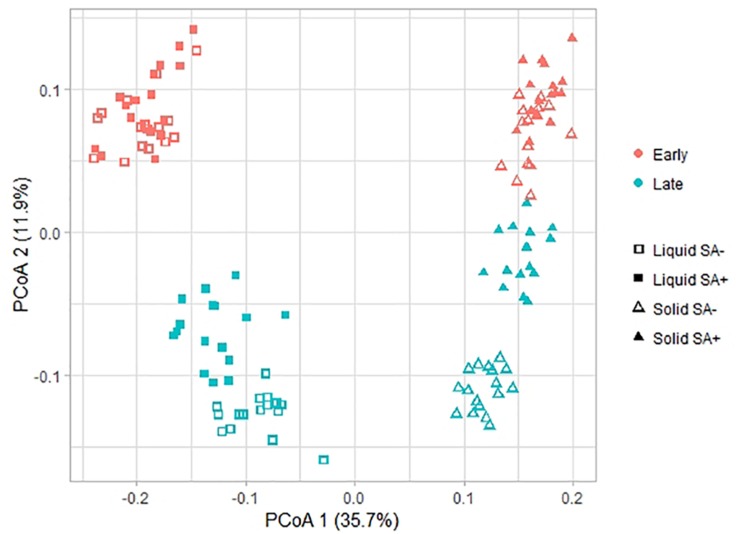
Changes in prokaryotic community composition associated with the time point, phase, and sucrose addition visualized as a principal co-ordinate analysis (PCoA) using weighted UniFrac distance metrics. Symbol shapes indicate the two phases, i.e., liquid and solid, from which the samples originated, colors indicate the different time points, i.e., early and late, and symbol fillings indicate the sucrose addition, i.e., with (SA+) or without (SA−). The percentage of variation explained is indicated on the respective axes.